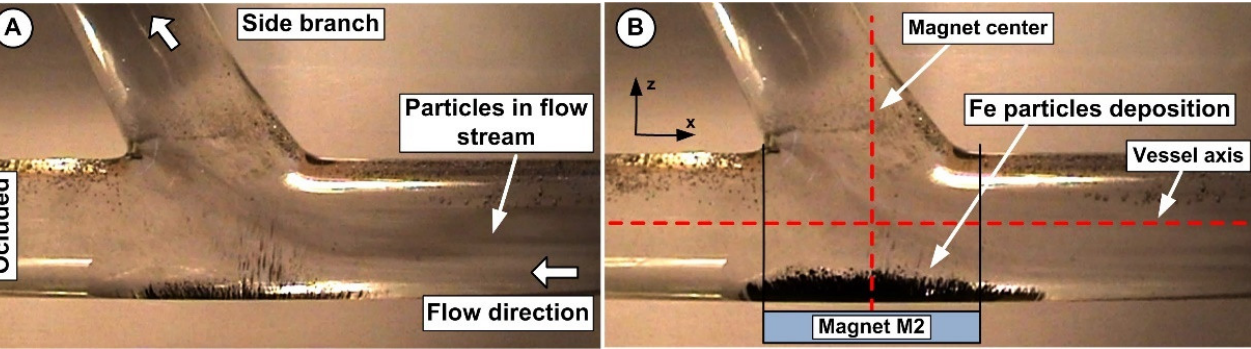
Figure 13. Flow field evolution in the artery bifurcation. ( A ) For a flow rate of Q1 = 362 mL/min and ( B ) for a flow rate of Q2 = 754 mL/min. The bifurcation induces the generation of two recirculation areas, one in the main artery (Vortex V1) and the other in the side branch (Vortex V2). The shape and extension of both vortices are directly related to the flow rate and the bifurcation angle.